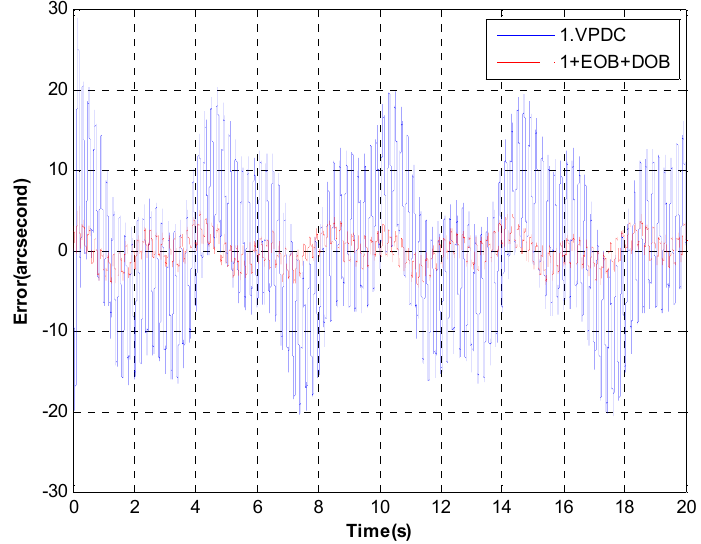
Figure 17. The residual error with the given signals of the target and disturbances.